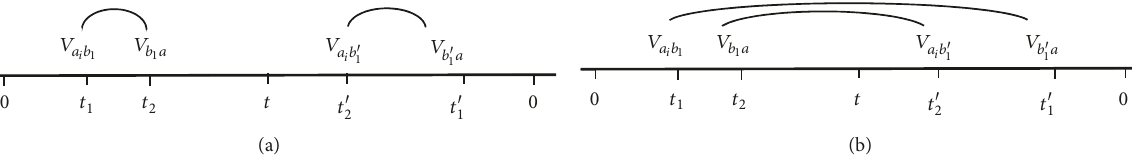
Figure 9: Two possible configurations for the pairing of matrix elements 𝑉 𝑎𝑏 that contribute to the second order of the survival probability ⟨𝑃 (2) (𝑡)⟩ 1󳨀→1